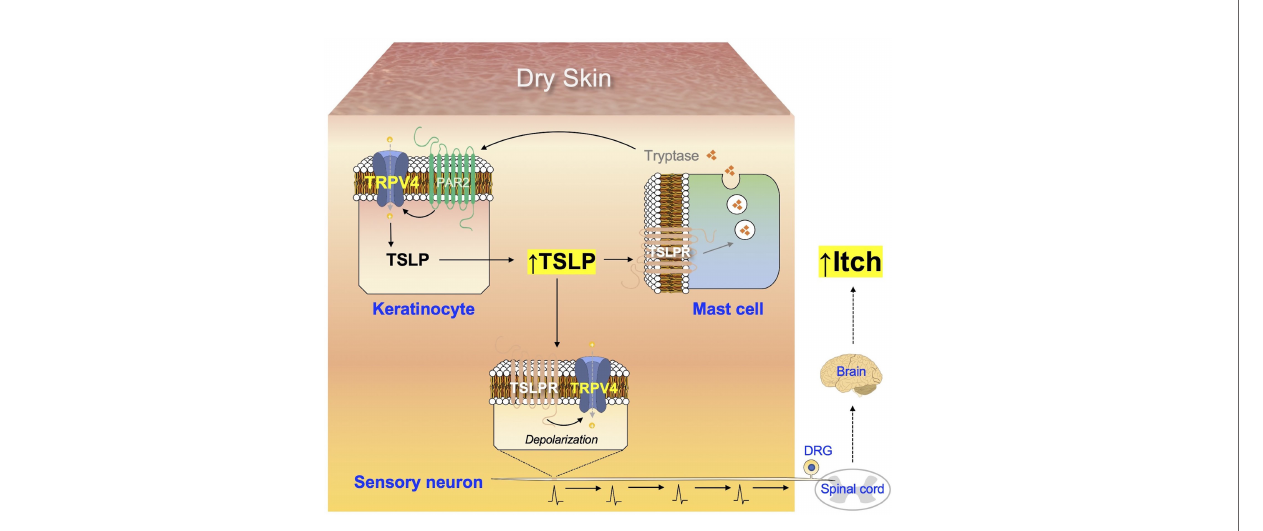
FIGURE 8 | Summary of the mechanism underlying dry skin-induced pruritus. The production of TSLP in keratinocytes increases under dry skin conditions, in a TRPV4-dependent manner. Additionally, TSLP acts on TSLPR in mast cells to promote the release of tryptase, which in turn stimulates the keratinocytes via PAR2 and TRPV4 to produce more TSLP, thus generating a positive feedback loop of increased TSLP production. TSLP can also act on TSLPR in sensory neurons to transmit electrical signals towards the spinal cord, which are conveyed to the brain and fi nally perceived as